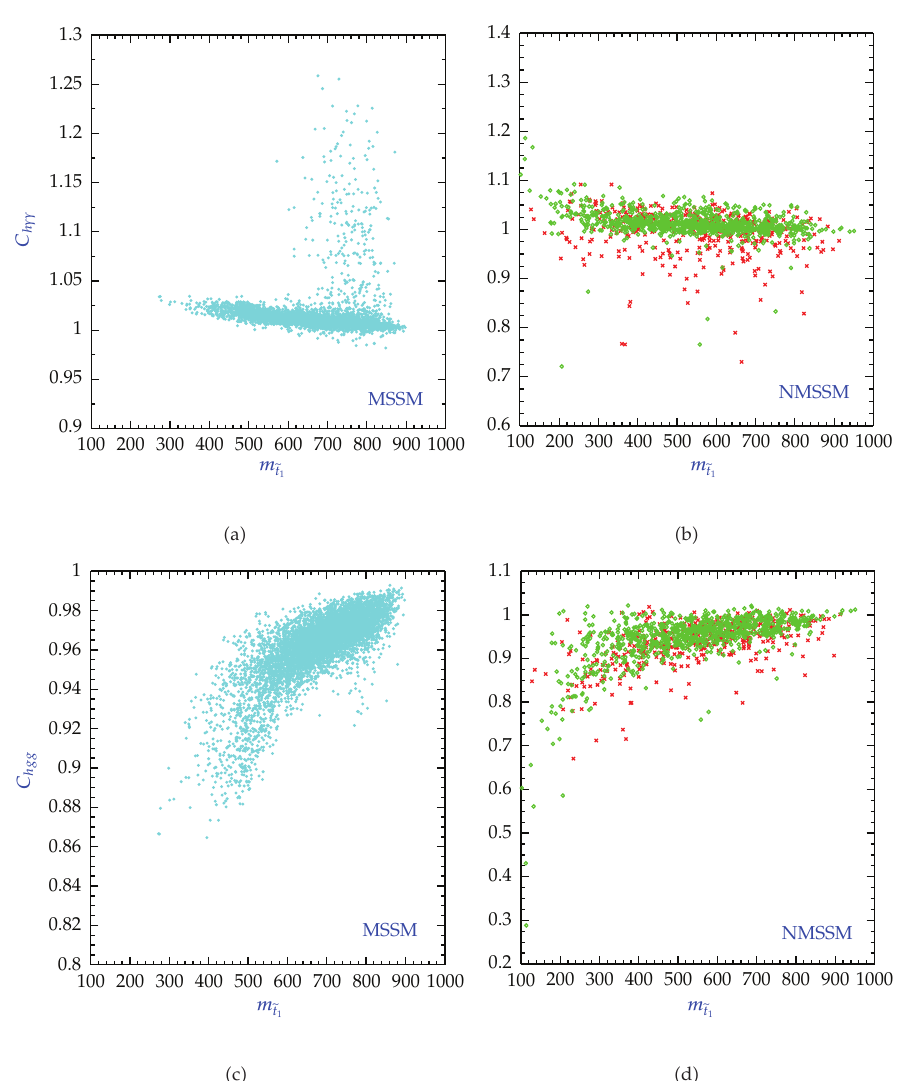
Figure 3: Same as Figure 1, projected in the planes of m (cid:4) respectively.